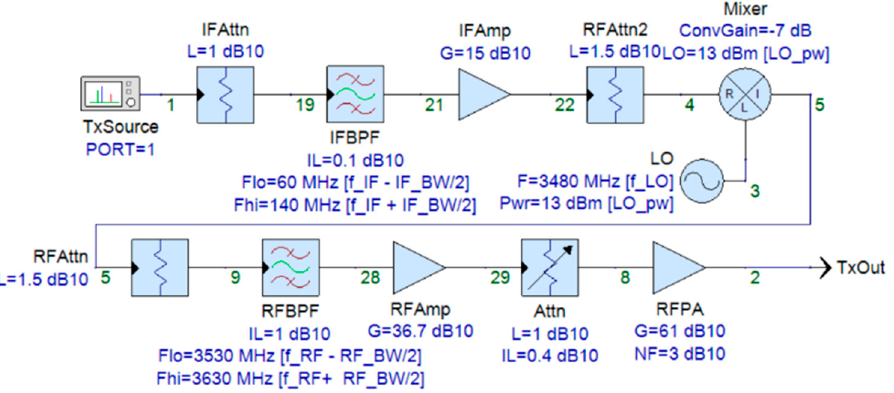
Figure A1. RF up-converter of TAR in TX_UpConv block of Figure 11.